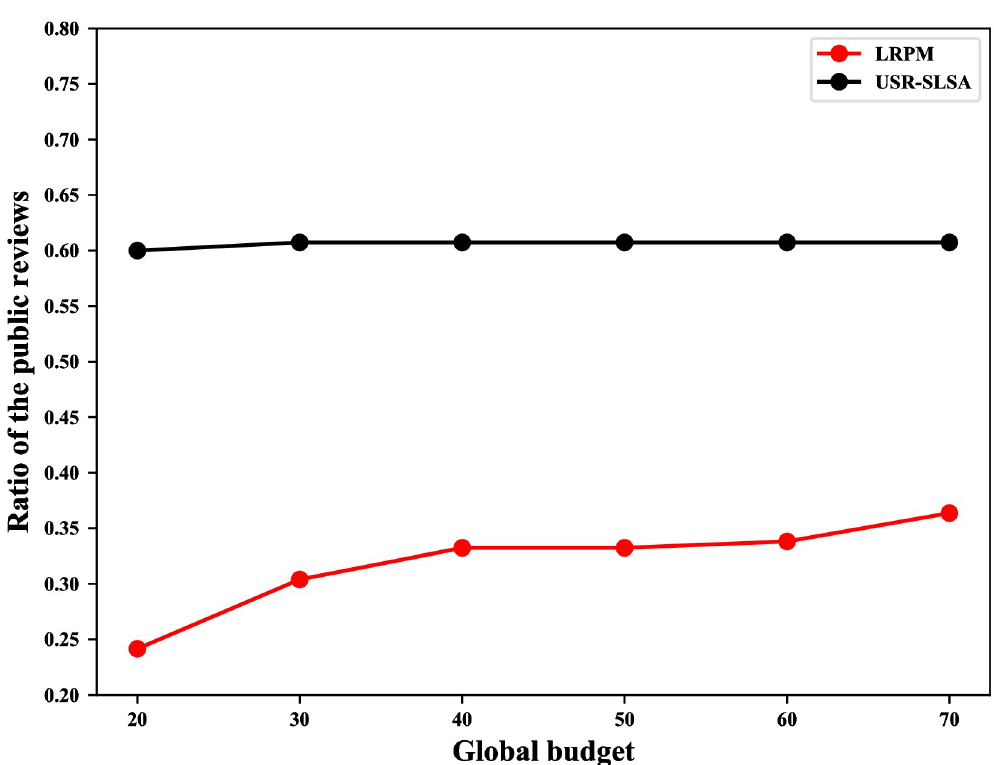
Fig 9. Ratio of the public reviews for different global budget (SPs for two methods receive different numbers of reviews).